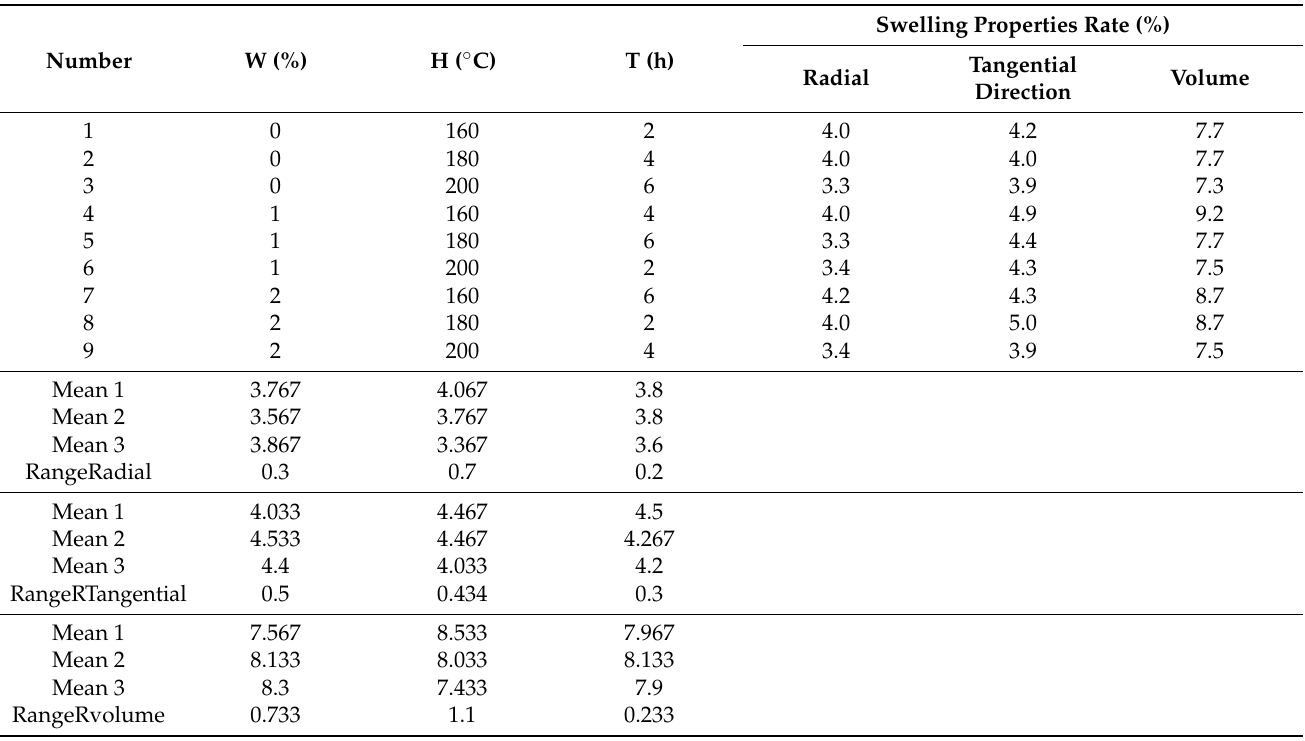
Table 13. Visual analysis of fully dry to the water-saturated swelling rate of impregnated heat- treated